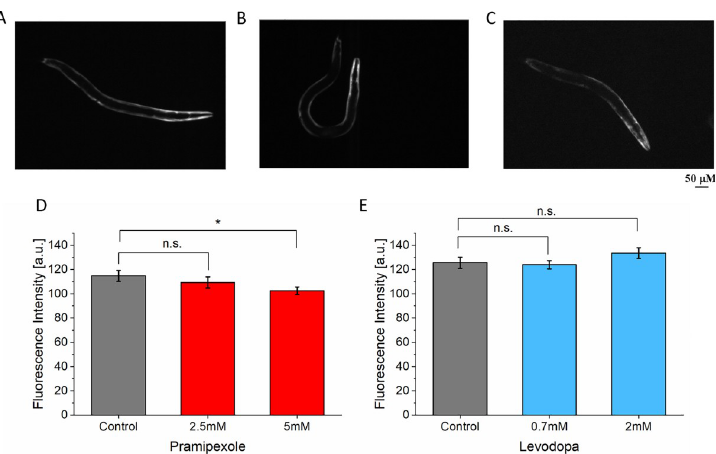
Fig 7. Quantification of fluorescence intensity of α -synuclein protein in NL5901. (A) Fluorescent image of α - synuclein protein accumulation before treatment (n = 31). (B) after treatment with 2.5 mM (n = 27). (C) after treatment with 5 mM (n = 24) pramipexole. (D) Fluorescence intensity of protein accumulation before and after treatment with pramipexole. (E) Fluorescence intensity of protein accumulation before (n = 35) and after treatment with levodopa 0.7mM (n = 32) and 2mM (n = 31). Significant differences were analyzed using t-test, error bars indicate s.e.m.